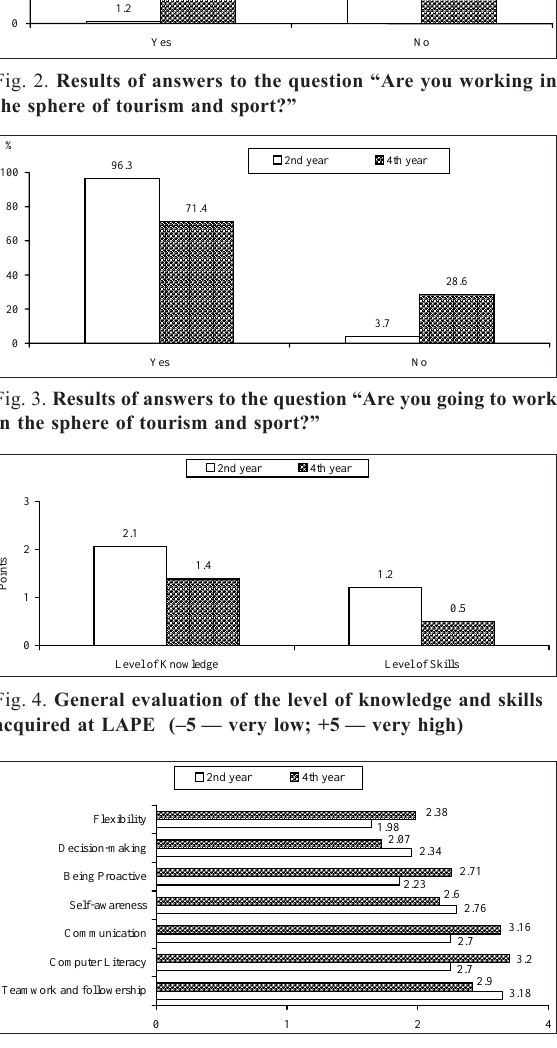
Fig. 5. Evaluation of enterprise competencies acquired at LAPE (7 most appreciated